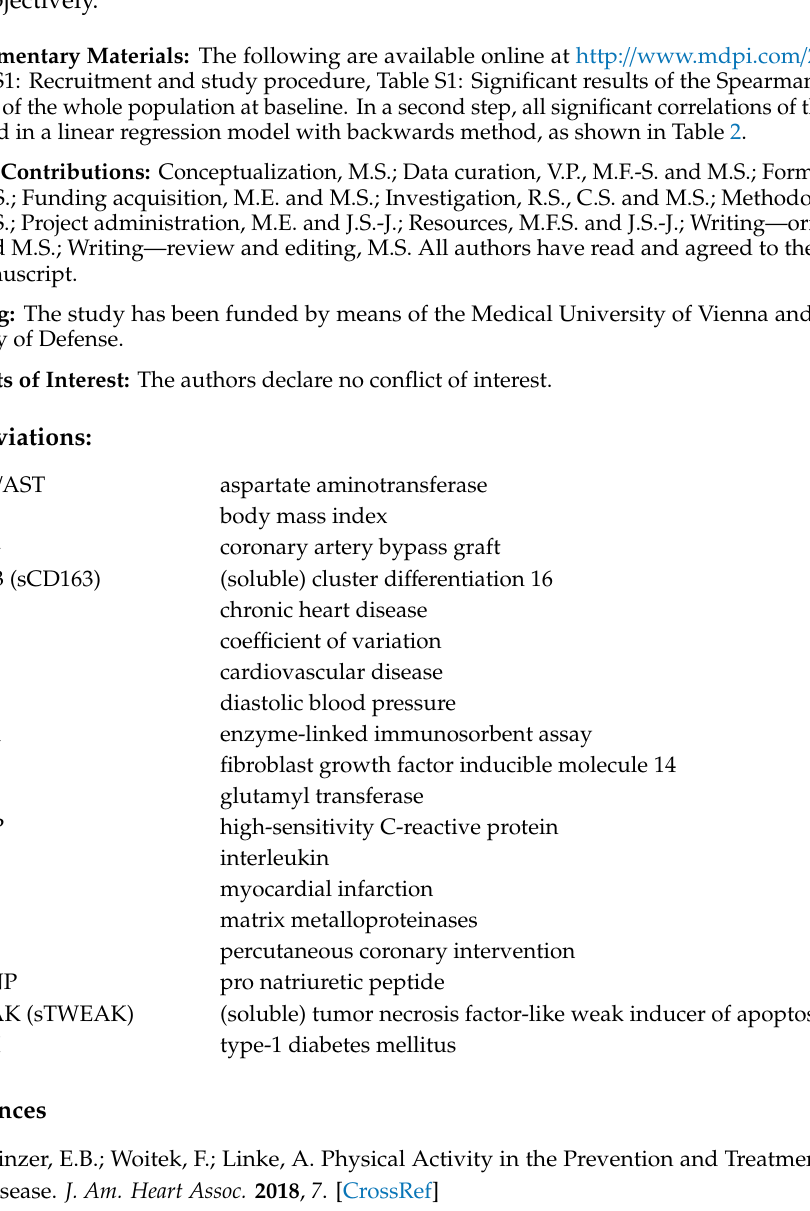
Figure S1: Recruitment and study procedure, Table S1: Significant results of the Spearman correlation using the data set of the whole population at baseline. In a second step, all significant correlations of the Spearman test were included in a linear regression model with backwards method, as shown in Table